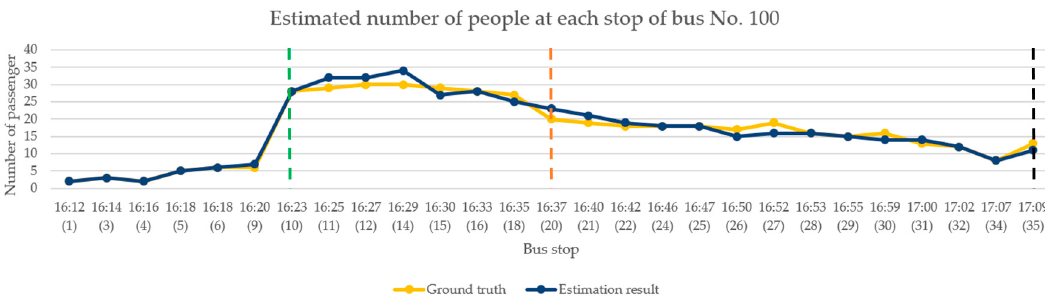
Figure 14. Continuous image analysis for afternoon.